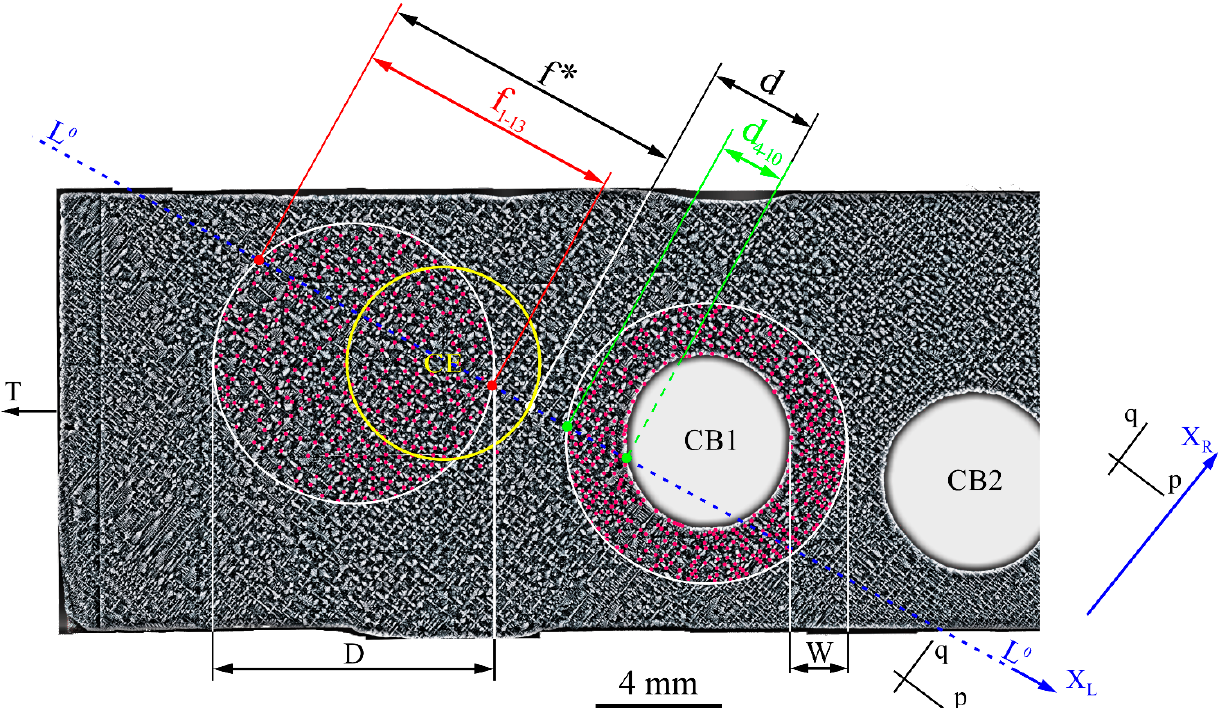
Figure 7. The dendritic structure obtained from the transverse section of the root fragment with marked f 1–13 and d 4–10 areas of PAS analysis. L 0 —trace of the longitudinal plane marked in Figure 1a, along which the dendritic structure of f 1–13 and d 4–10 areas on the left fragment of surface L, visible in Figure 6, was visualized.